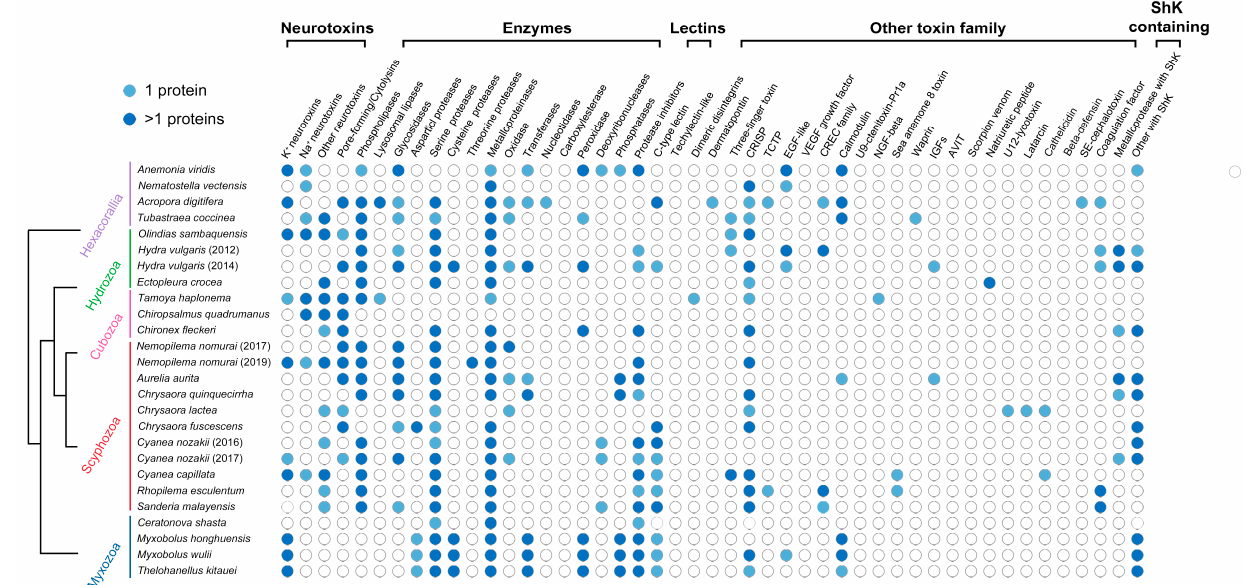
Figure 4. Presence of toxin families in cnidarian proteomes. A schematic tree of Cnidaria is shown on the left. Circles indicate the presence of a toxin family in a species, light blue indicates that only one protein was identified in the nematocyst proteome, and dark blue indicates that more than one protein was identified in the nematocyst proteome.